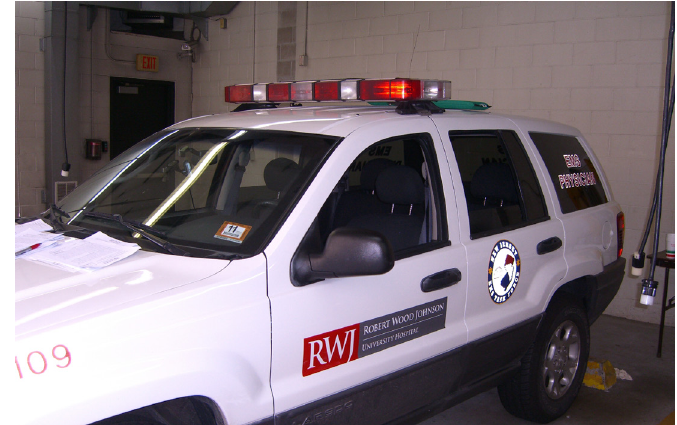
Figure 2. Vehicle used for